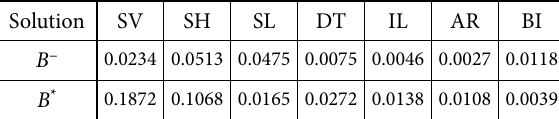
according to TOPSIS method